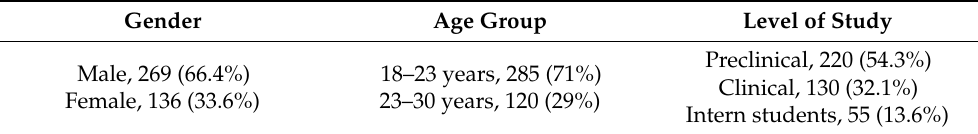
Table 1. Characteristics of participants/ n (%)—(no = 405).